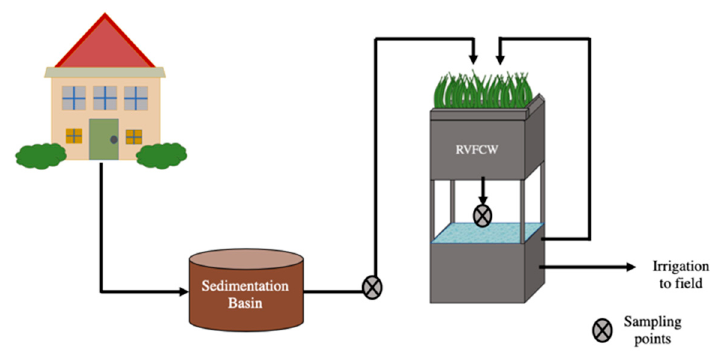
Figure 1. Recirculating vertical flow constructed wetland schematic.